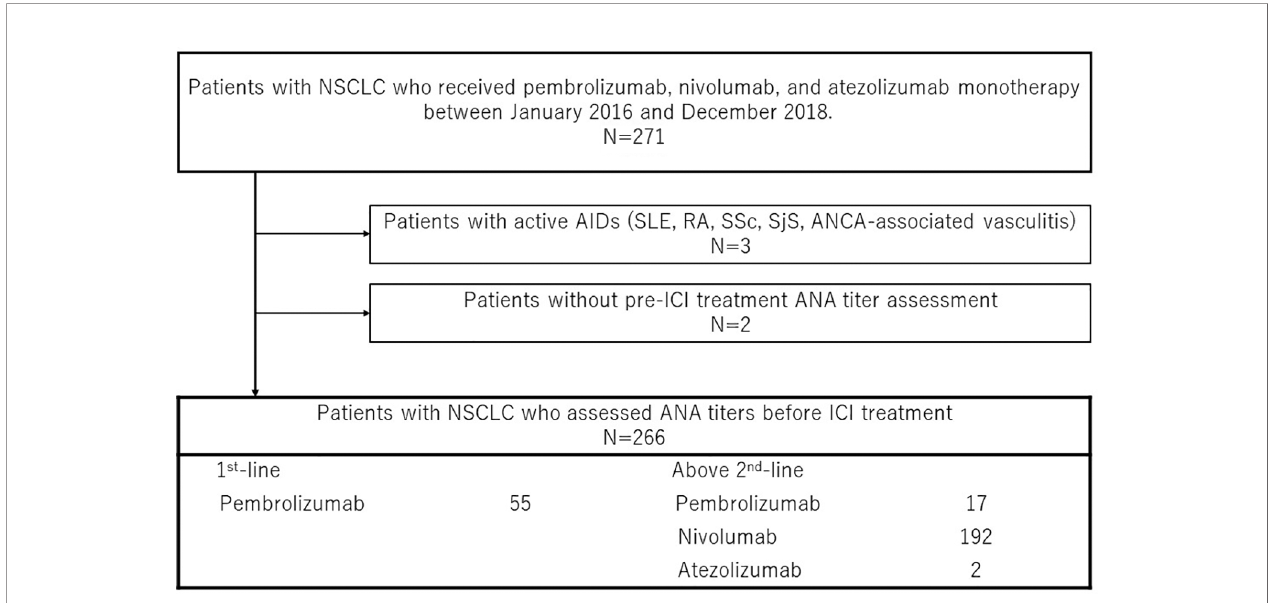
FIGURE 1 | Study schema, antinuclear antibody (ANA) titers in 271 patients with advanced NSCLC were assessed before anti-PD-1/PD-L1 antibodies monotherapy administration at Saitama Medical University, International Medicine Center. Patients treated previously with other ICIs (Pembrolizumab and nivolumab including 1 st - line therapy) or who did not have pre-treatment ANA titers before ICI or who had active major AIDs were excluded. Nivolumab, pembrolizumab, and atezolizumab were administered to 192, 72 (55 as 1 st setting), and 2 patients. PFS, progression-free survival; OS, overall survival; ICI, immune checkpoint inhibitors; PD-1, programmed death-1; PD-L1, programmed death ligand 1; ANA, antinuclear